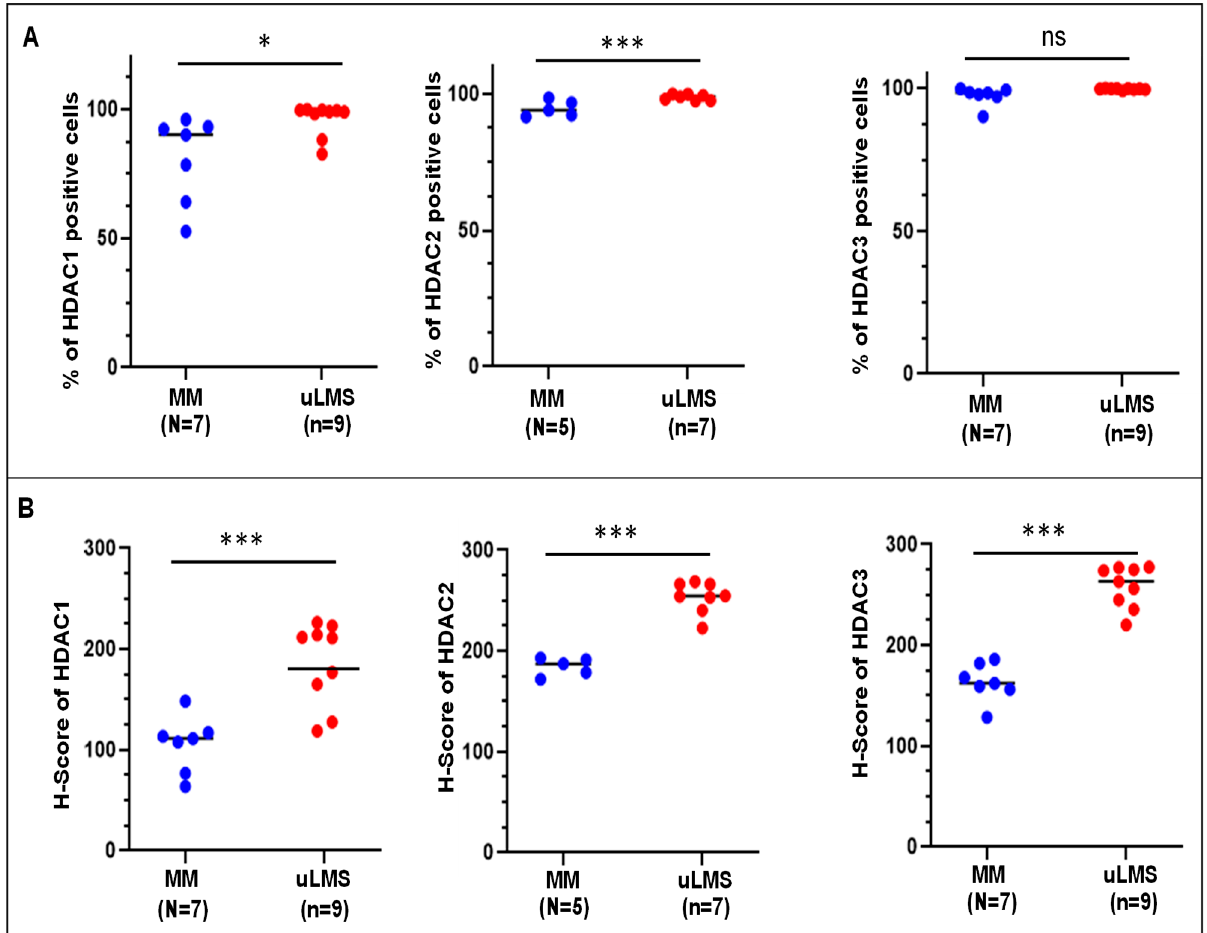
showed the density map of HDAC1, 2, and 3 for the same representative case. Blue color: negative; Yellow color: low expression; brown color: moderate expression; red color: strong expression. Scale bars in black color: 100 µm; Scale bars in red color: 1mm